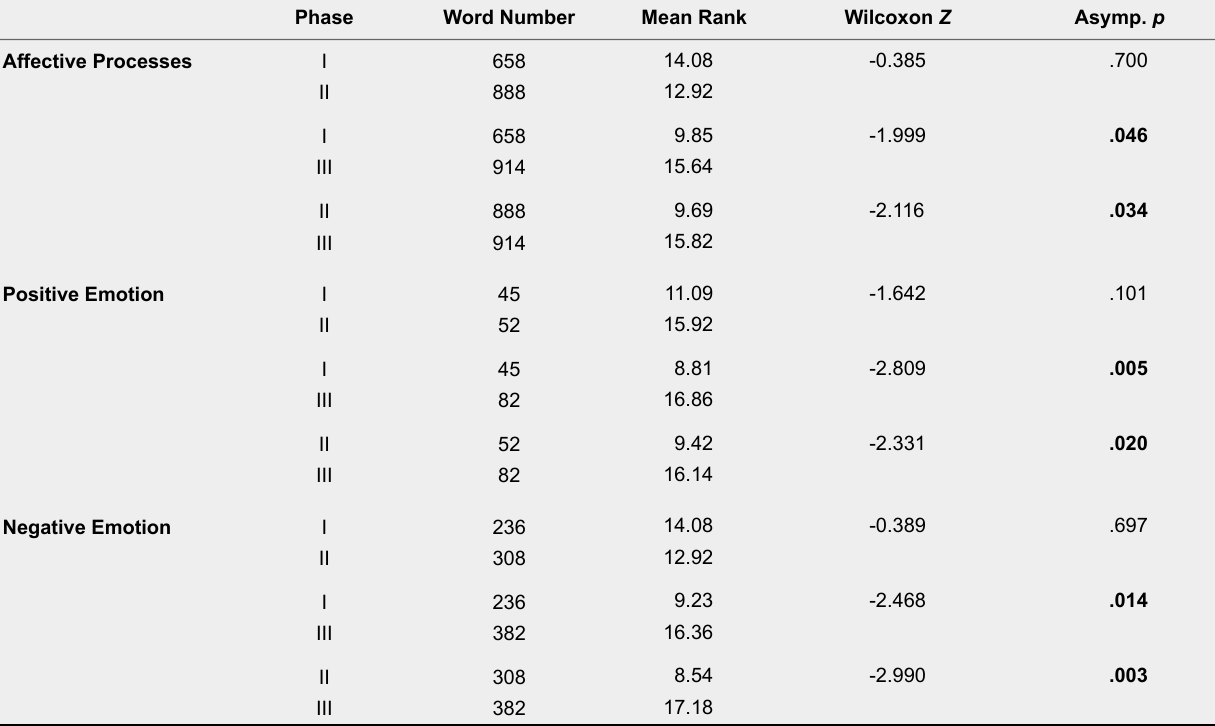
Wilcoxon Test for the Emotional Dimension of Mentalization